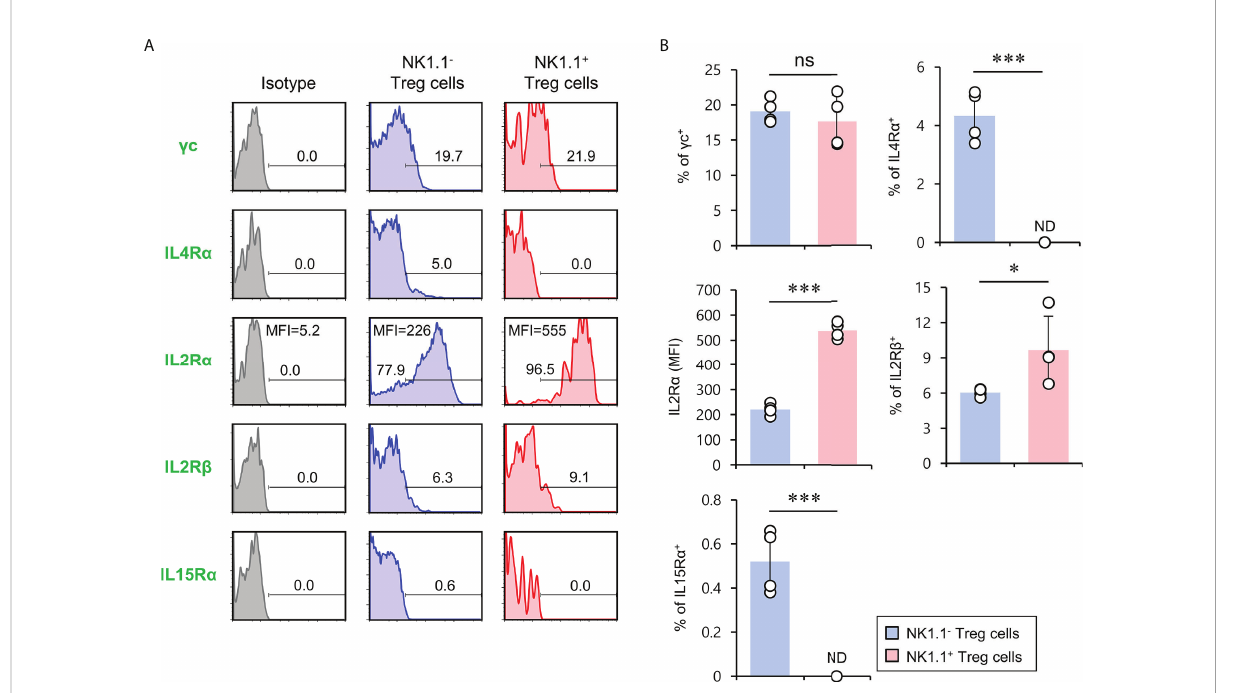
FIGURE 3 The expression of members of the common cytokine receptor g -chain ( g c) family of cytokine receptors on NK1.1 + Treg cells. Splenic CD4 + T cells were isolated from 8-week-old Foxp3(GFP) CD1d KO B6 mice. (A, B) Cell surface expression of the common cytokine receptor g -chain ( g c) family cytokine receptors (i.e., IL2R g , IL4R a , IL2R a , IL2R b , and IL15R a ) on NK1.1 - Treg (NK1.1 - CD4 + Foxp3(GFP) + ) and NK1.1 + Treg (NK1.1 + CD4 + Foxp3(GFP) + ) cells were evaluated by fl ow cytometry. (A) Representative FACS histogram; (B) summary fi gures. The mean values ± SD ( n = 4; per group in the experiment; Student ’ s t-test; * p < 0.05, *** p < 0.001) are shown. One representative experiment of three experiments is shown. ns, not signi fi cant; ND, not